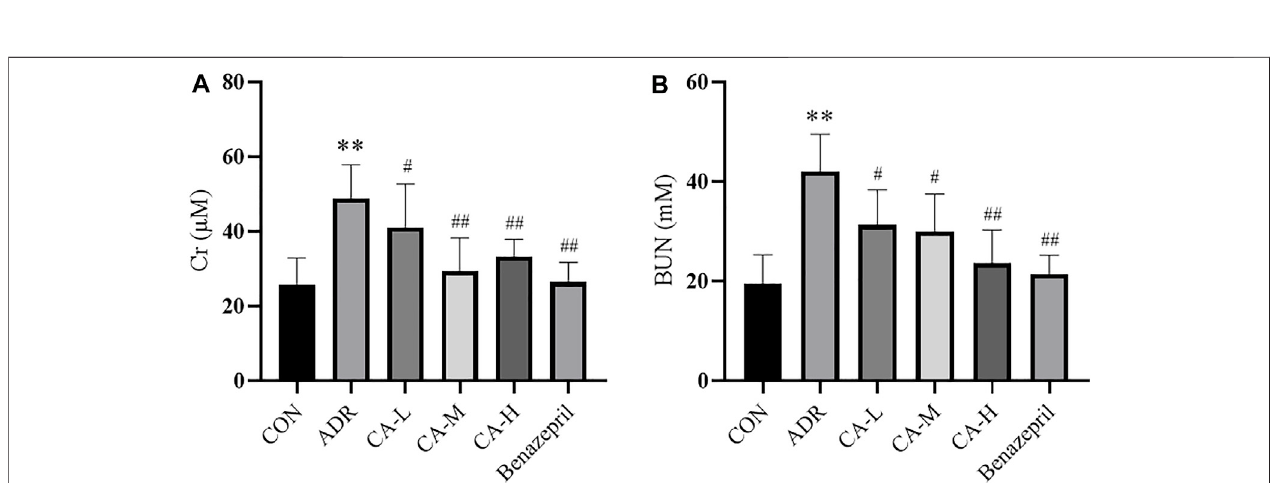
FIGURE 11 | 24 h urine volume (A) and urine protein content (B) in rats. ** p < 0.01 vs CON group; # p < 0.05, ## p < 0.01 vs ADR group.